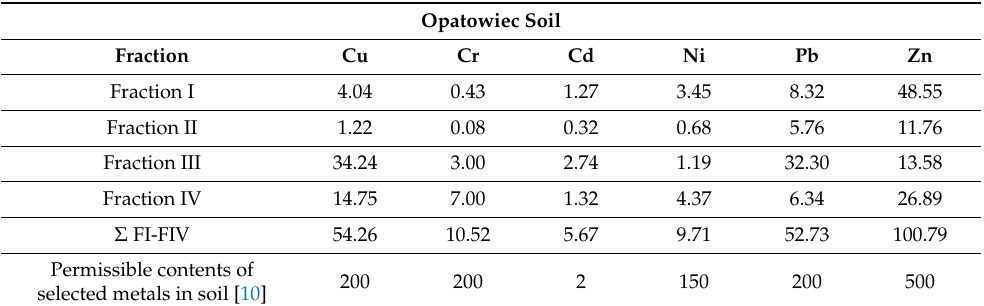
Table 3. Chemical speciation of heavy metals in the soil from Opatowiec in the Swietokrzyskie Voivodeship (mg/kg).